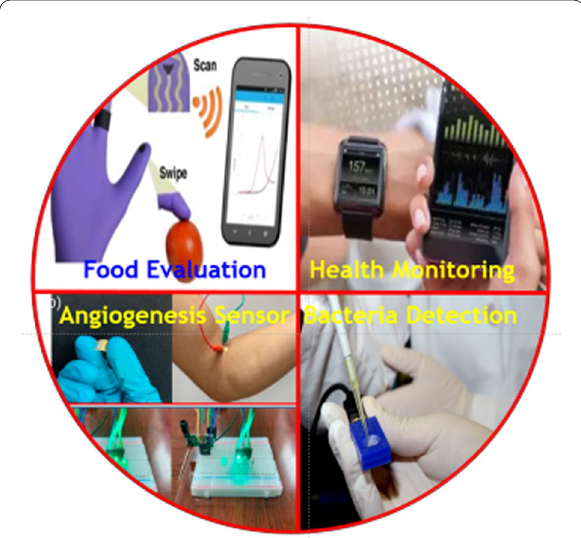
Fig. 1 Portable electrochemical sensors and biosensors for various